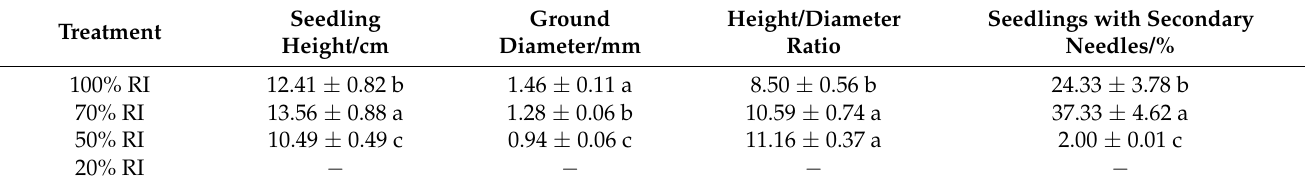
− − Different letters indicate significant differences ( p < 0.05) between different light intensities accord- ing to ANOVA and an LSD test, n = 30; “ − ” means all seedlings had died. Abbreviations: RI, rela- tive irradiance.